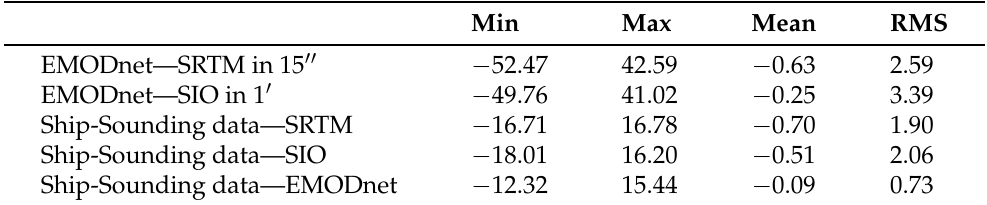
Table 4. Depth differences between the ship-sounding data and different existing digital terrain models (unit: